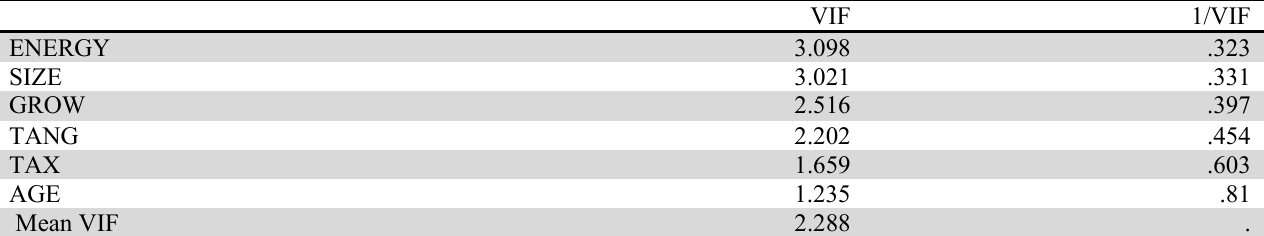
Variance Inflation factor (VIF)